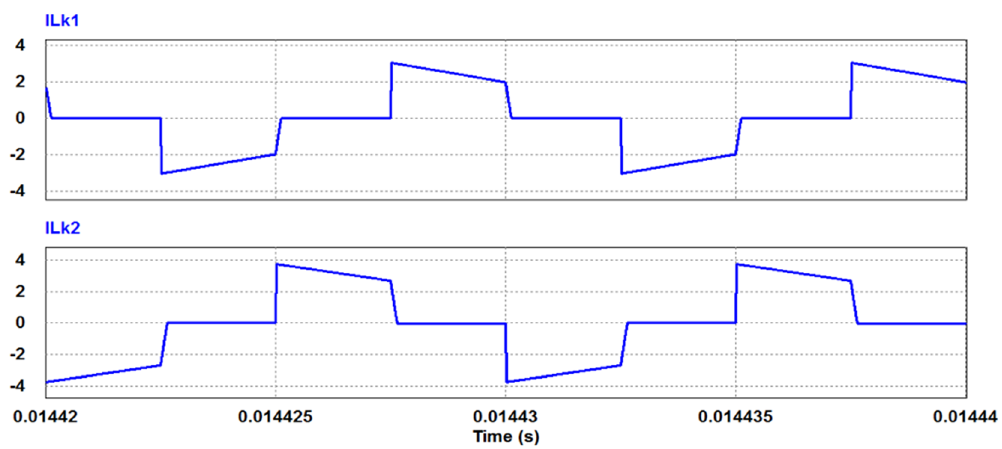
Figure 14. Transformer Leakage